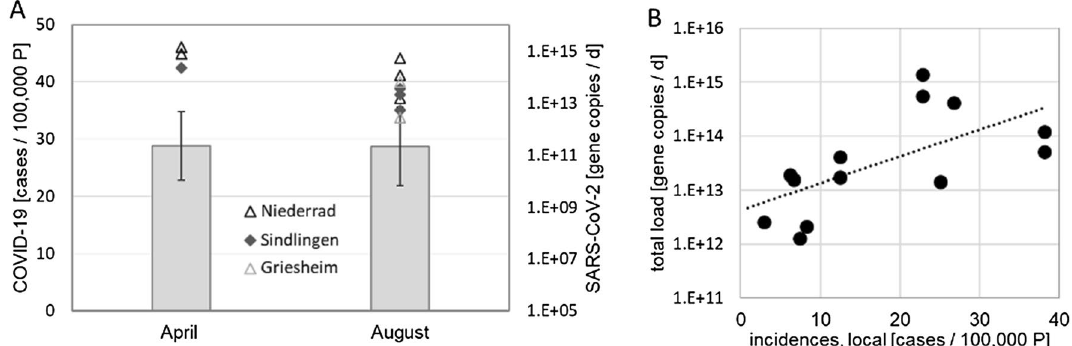
Figure 2. ( A ) Comparison of the results from April and August 2020, bars represent a three week average around the maximum number of cases per 100.000 persons (P), symbols refer to the respective SARS-CoV-2 RNA loads; ( B ) Correlation between the total load of SARS-CoV-2 gene copies (sum of the loads to both WWTPs) and incidences in Frankfurt am Main 100.000 people at the maximum and only 10 in August. Therefore, we used the COVID-19 cases and the cor- responding SARS-CoV-2 RNA loads to the WWTPs both in April and August to compare both time points of the pandemic (Fig. 2A). Our results revealed that the load of SARS-CoV-2 RNA in the wastewater samples was only slightly higher in April with a maximum of 1.4 × 10 15 copies/d compared to a maximum of 5.37 × 10 14 copies/d in August for individual influent wastewater samples. Additionally, we evaluated the correlation between the incidences reported against the sum of the SARS-CoV-2 RNA load measured in all the samples (Fig. 2B). It is clearly visible that with the increase in incidences, a corresponding increase in the viral load was observed as also shown in the Spearman’s rank correlation coefficient r s of 0.7464 (p (2-tailed) = 0.00217). However, there is a certain scat-